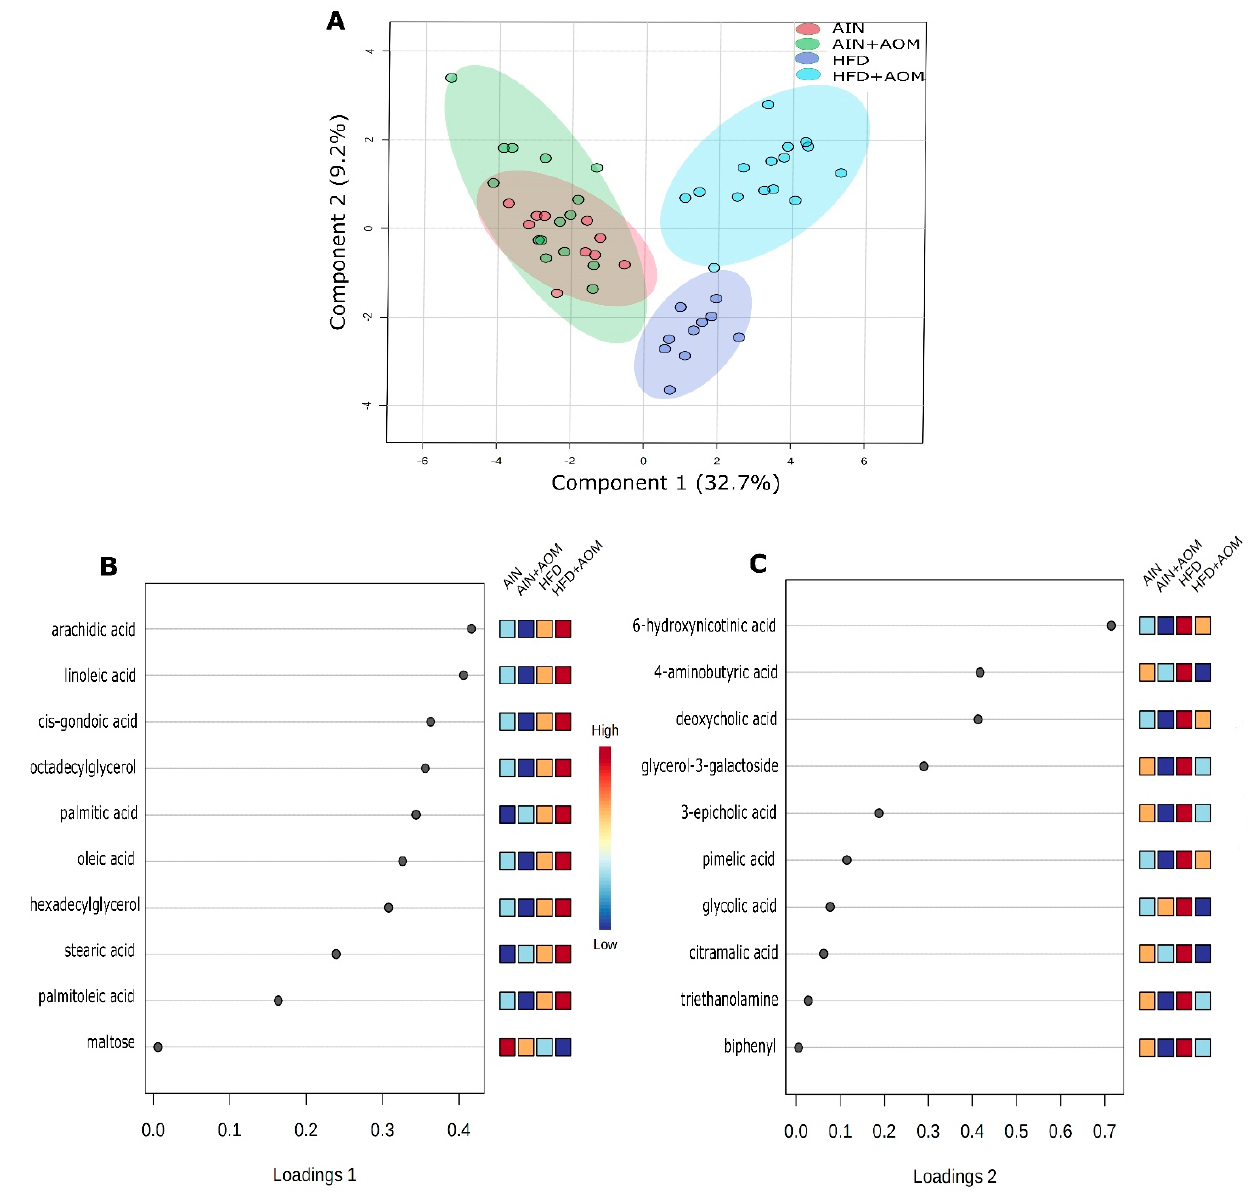
Figure 1. Two-dimensional (2D) sPLS-DA of the 4 experimental groups ( A ) and loading plots of 10 metabolites which are most significant in group separation among the four groups for component 1 ( B ) and component 2 ( C ). Mice without AOM treatment (control), n = 10/group (AIN or HFD group). Mice with AOM treatment, n = 15/group (AIN + AOM or HFD + AOM group).